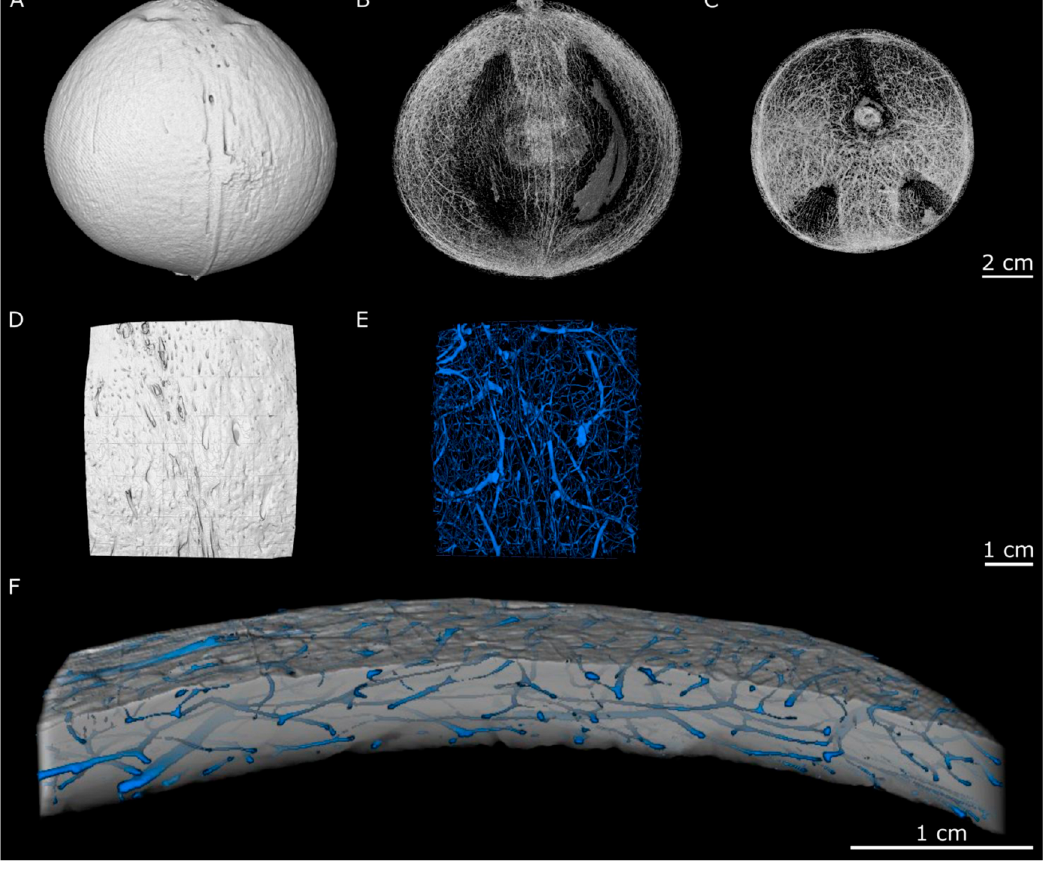
Figure 2. µCT reconstructions of a coconut fruit scanned at two resolutions: 150 µm ( A – C ) and 42 µm ( D – F ). Side view of the coconut endocarp showing the outer surface ( A ) and the course of the vascular bundles ( B ). Top view of the endocarp with highlighted vascular bundles ( C ). Top view of a smaller endocarp volume scanned at higher resolution showing the outer surface ( D ) and the course of the vascular bundles ( E ). The higher magnification also reveals smaller vascular bundles, which span a strongly branched network between the larger vascular bundles. In the enlarged side view of the smaller endocarp volume, the vascular bundles are observed running almost parallel to the outer surface of the endocarp ( F ). Images ( B , C ) are kindly provided by the Shimadzu Corporation.